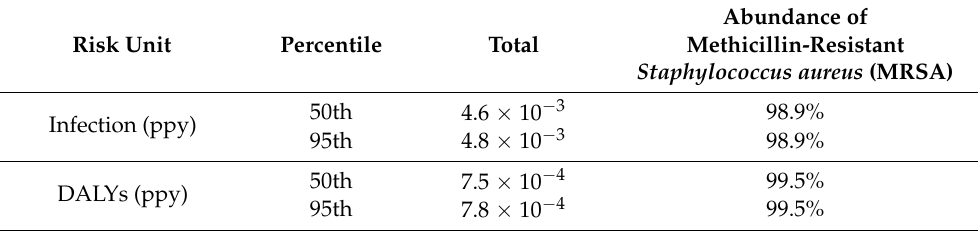
Table 4. Risks associated with direct use of river